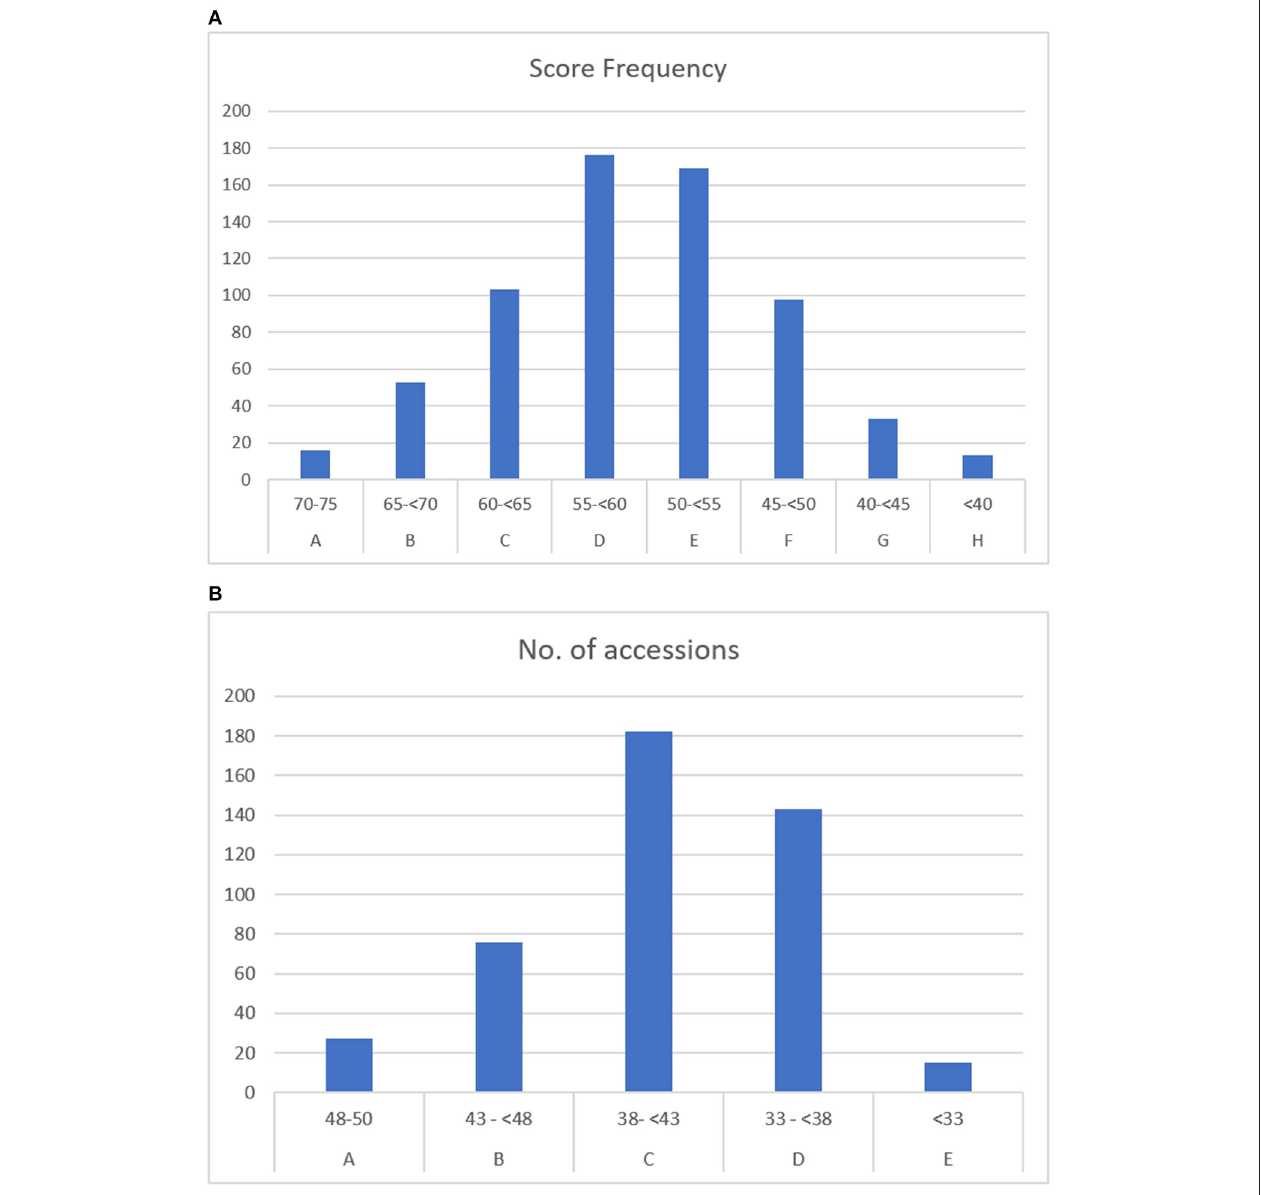
FIGURE 4 | (A) Overall score frequency of wild accessions in priority groups A to H. (B) Overall score frequency of cultivated accessions in priority groups A to